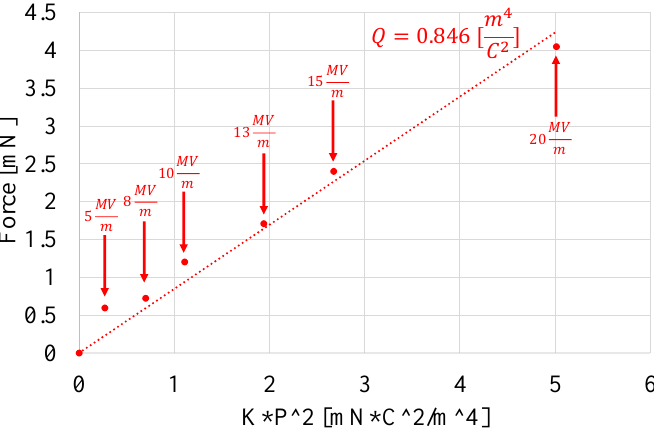
Figure 16. Linear fitting of electrostrictive coefficient Q for the P(VDF-TrFE-CTFE) film (see Equation